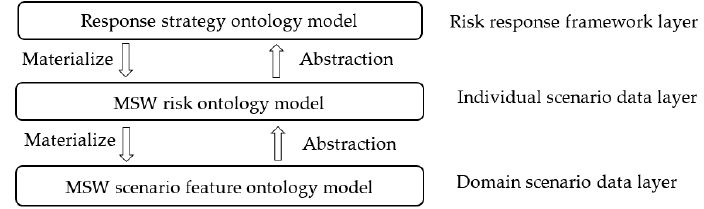
Figure 1. Municipal solid waste (MSW) crisis ontology model construction framework.